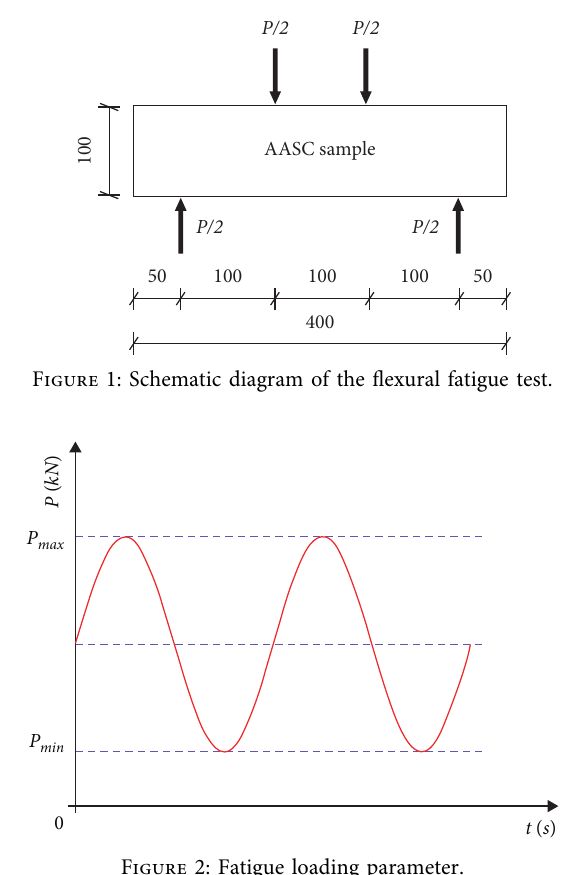
Figure 2: Fatigue loading parameter. Table 3: Outline of samples preparation and experimental plan.